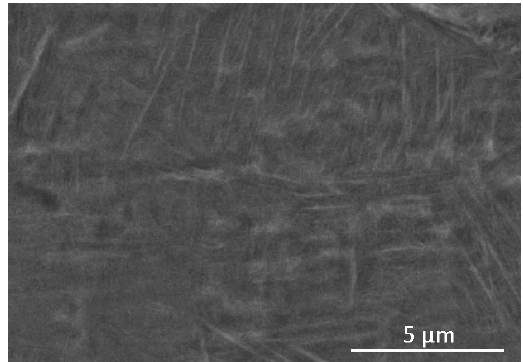
Figure 6. Microstructure of the Ti6Al4V deposited coating.